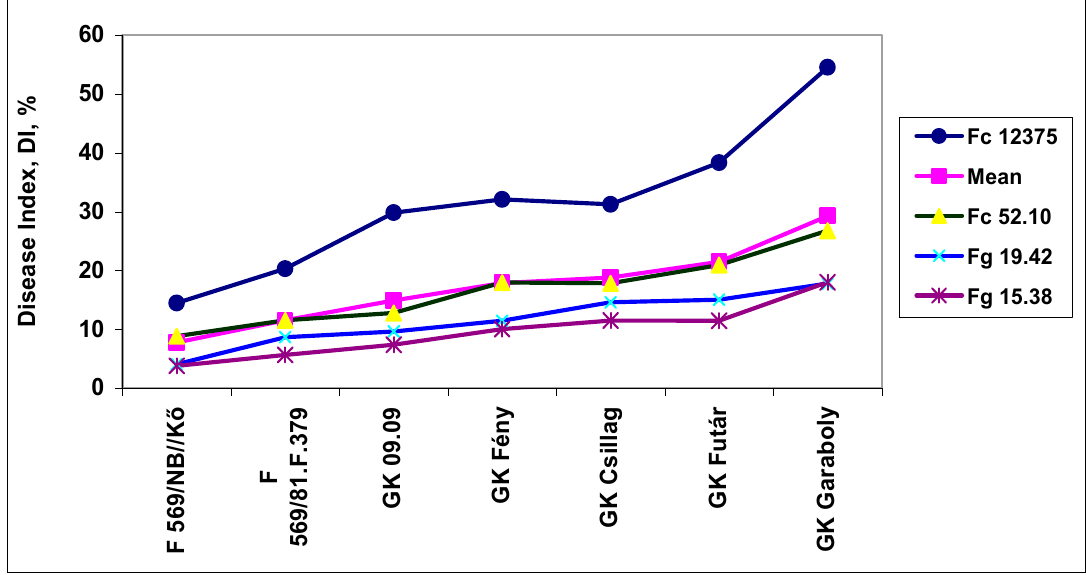
Figure 3. The resistance of winter wheat genotypes to FHB. DI of the seven cultivars at the different isolates, Szeged, 2013 and 2014. LSD 5% between any data points except mean—1.92; for the mean data— 0.96.